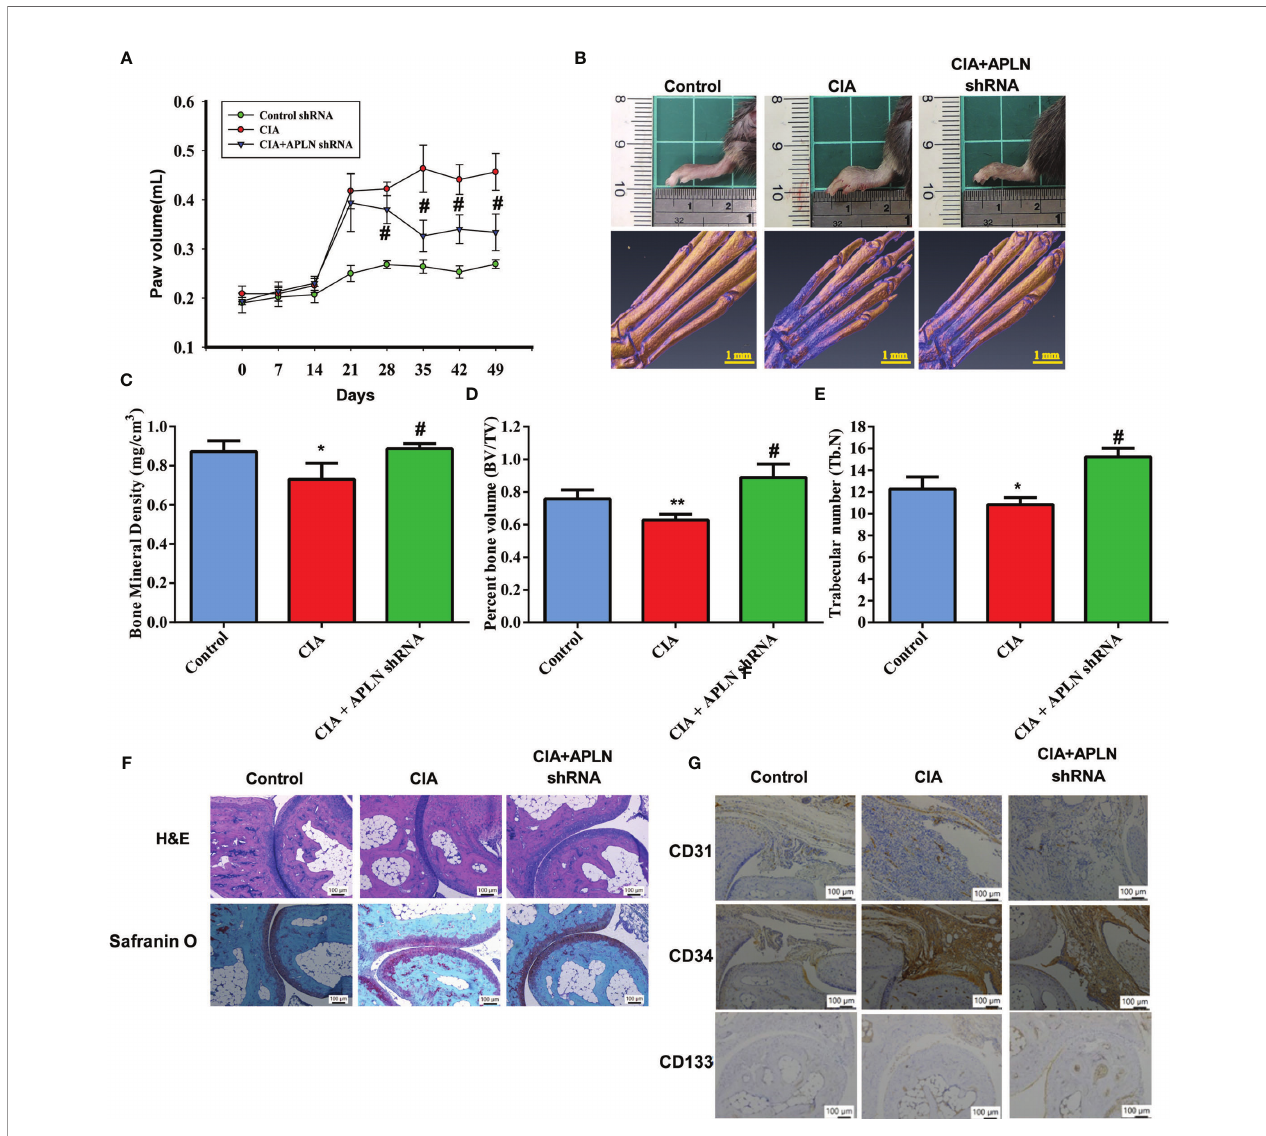
FIGURE 6 | APLN knockdown reduces angiogenesis and the severity of RA in vivo . CIA mice received intra-articular injections of 7.1×10 6 PFU APLN shRNA or control shRNA on day 14 and were euthanized on day 49. (A) In comparisons of digital plethysmometer values for the amounts of hind paw swelling in the CIA and APLN shRNA groups, the statistical comparisons were not signi fi cant on days 14 and 21 (p=0.5 and p=0.3, respectively), but they were signi fi cant change on days 14, 21, 28,35,42 and 49 (p=0.001, p<0.0001, p<0.0001, and p<0.0001, respectively). (B) Representative micro-CT images of the hind paws taken on day 49. (C – E) Micro-CT SkyScan Software quanti fi ed bone mineral density, bone volume and trabecular numbers. (F, G) Histological sections of ankle joints were stained with H&E or Safranin O and immunostained with CD31, CD34 and CD133. * p < 0.05 versus the control group; # p < 0.05 versus the APLN-treated group. * p < 0.05 and ** p < 0.01 versus the control group; # p < 0.05 versus the CIA